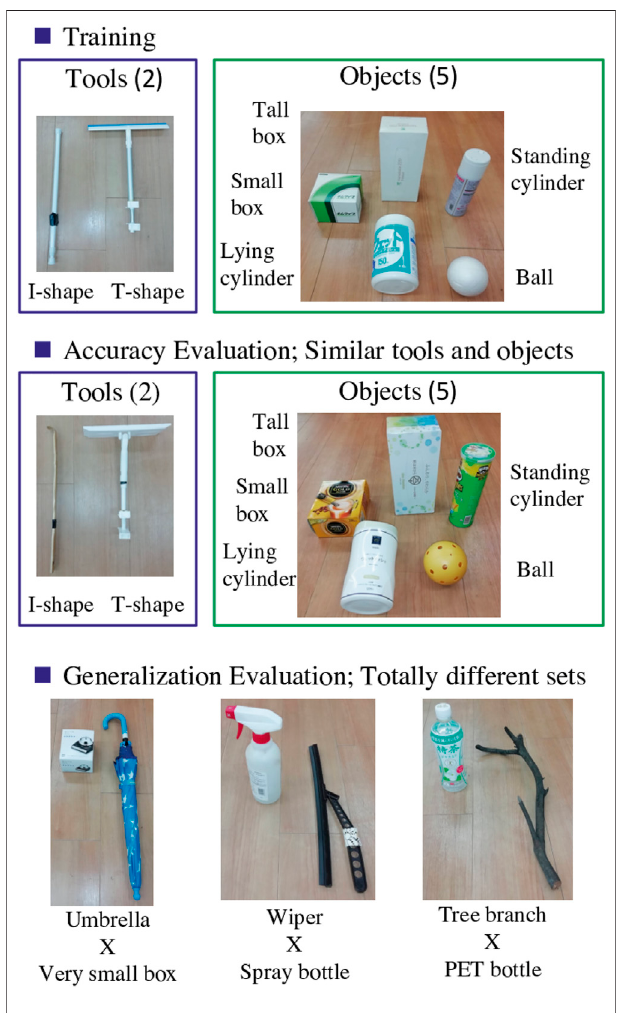
FIGURE 2 | Tools and objects used in the experiments. The upper images show the training setup. The middle images show untrained tools and objects similar to trained ones. These are used to evaluate accuracy of the tool-use model. Images at bottom show untrained tools and objects completely different from trained ones, used to test the model ’ s generalizability.